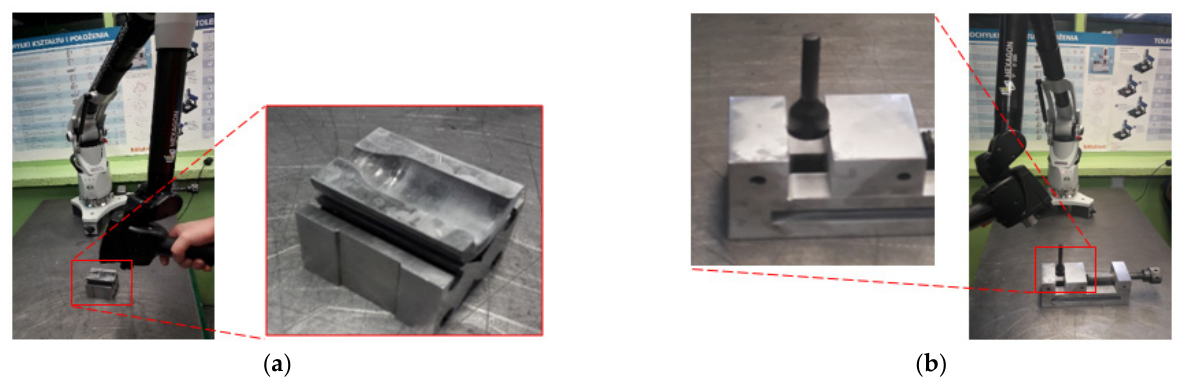
Figure 5. Station with measuring arm ROMER AbsoluteArm 7520si, integrated with a laser scanner RS3, used for the 3D measurements: ( a ) die measurement; ( b ) forging measurement.